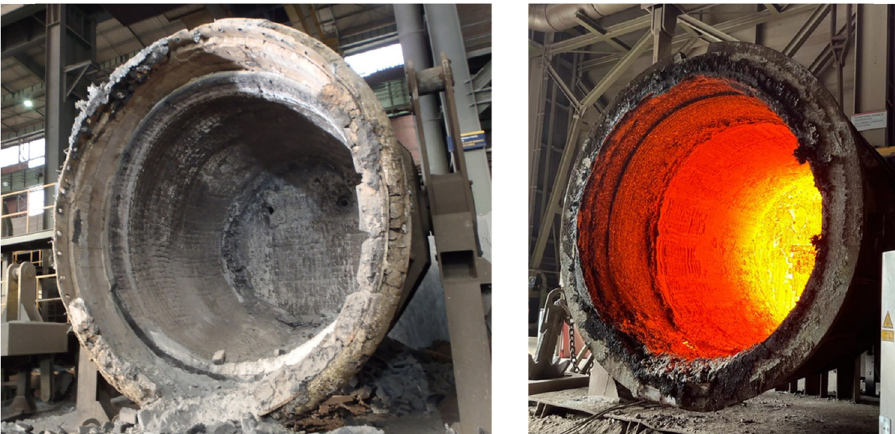
Figure 5: Left: Used steel ladle taken out for demolition of lining. Right: Hot steel ladle, after visual inspection and waiting for next